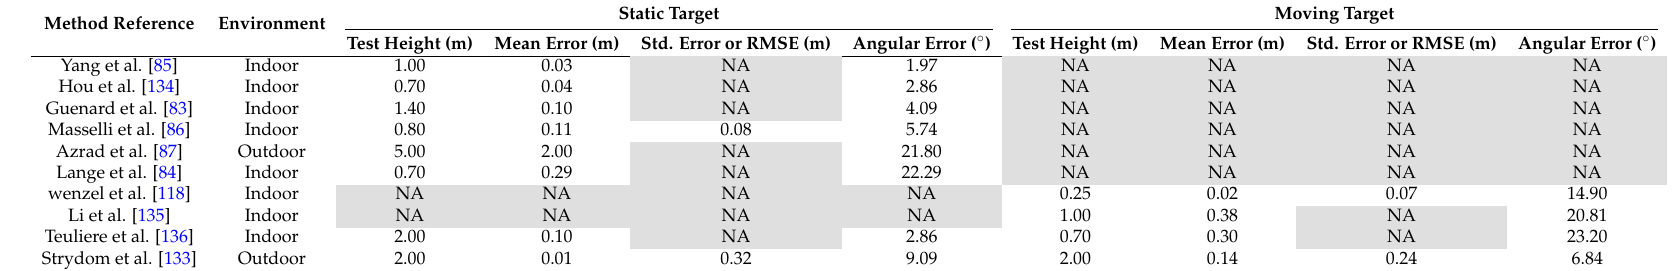
Table 3. Comparison of various following and interception techniques for static or moving targets, where NA denotes fields that are not applicable/supplied. The angular error defines an error cone, which represents the deviation of the UAS from the desired position. The angular measure accounts for the different test